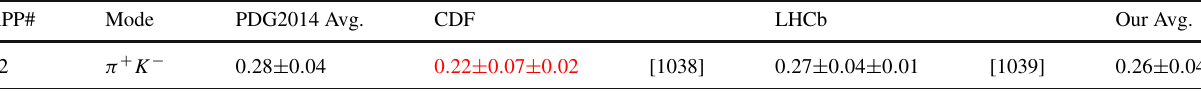
Table 246 CP asymmetries of charmless hadronic B 0 s decays. Where values are shown in red (blue), this indicates that they are new published (preliminary) results since PDG2014